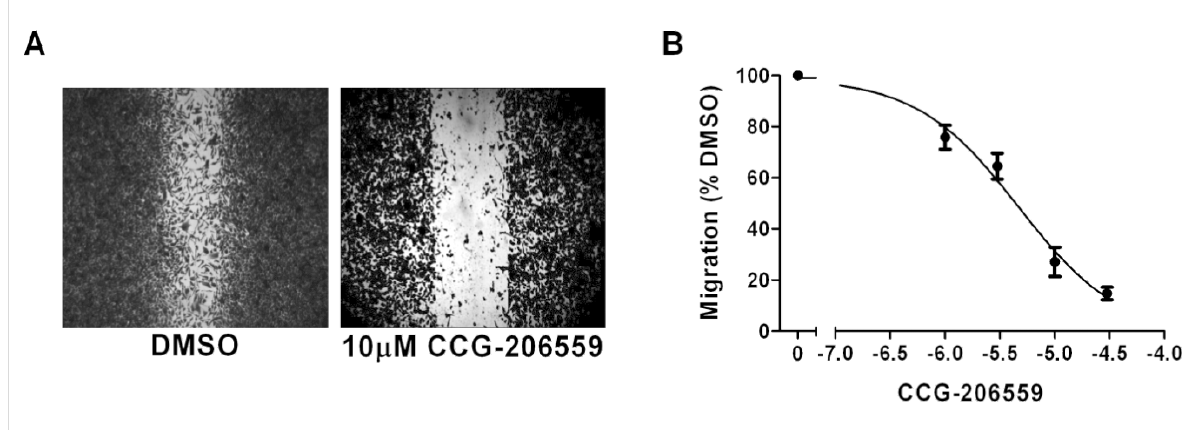
Figure 3: Photoprobe 24 (CCG-206559) retains biological activity to block prostate cancer migration. A. Cellular migration determined by wound assay. PC-3 prostate cancer cells were grown to confluence in 12-well plates and a scratch was made with a 200 µL pipette. Images were taken at the beginning of the experiment and after 24 h in DMEM containing 0.5% FBS and the indicated concentration of 24 or 0.1% DMSO. After 24 h the cells were stained with crystal violet to produce high-contrast images. Shown are examples of 10 μ M 24 and DMSO after 24 h, from experiments with similar initial wound areas as determined by using image analysis software. B. Quantification of wound assay migration. The change in migration over 24 h was determined by the difference between the area of the wound after 24 h and the initial area of the wound. The percent inhibition was plotted by normalizing the compound-treated cells to the DMSO control. Results are expressed as the mean (±SEM) of triplicate experiments. A nonlinear least-squares regression curve was fit for CCG-206559 inhibition of migration, IC 50 = 4.7 μ M.